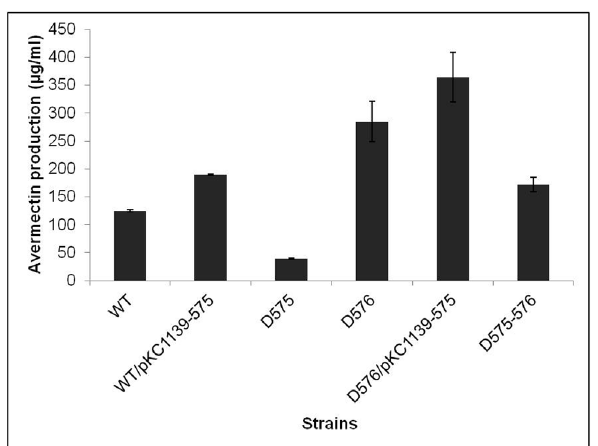
Figure 6. Comparison of avermectin production in SAV575 mutant strains. The fermentation products were analyzed by HPLC following cultivation in FM-I for 10 days. WT/pKC1139-575, ATCC31267 containing SAV575 overexpression vector; D575, SAV575 mutant; D576, SAV576 mutant; D576/pKC1139-575, D576 containing SAV575 overex- pression vector; D575-576, SAV575-SAV576 double mutant.